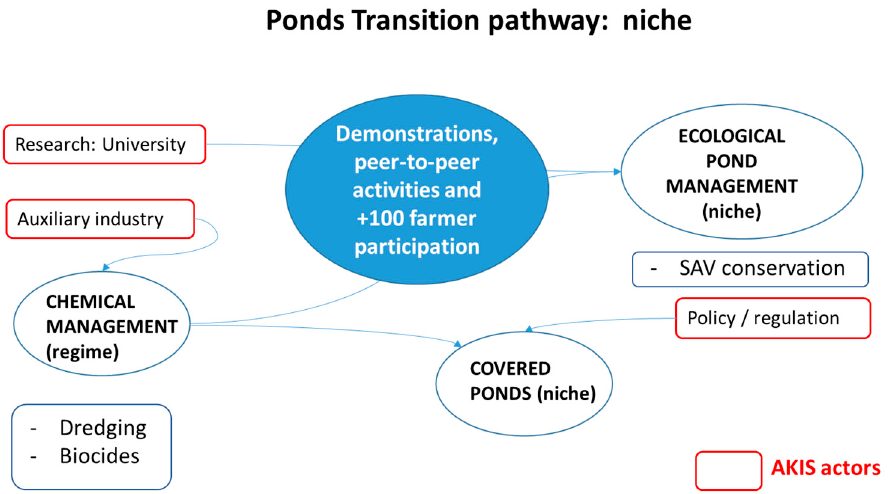
Figure 6. PONDs transition pathway (authors’